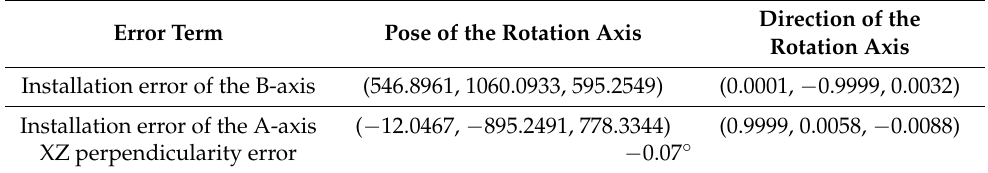
Figure 9. The measurement data’s distribution: ( a ) Before calibration; ( b ) after the calibration of the pose of the rotation axis; ( c ) after the calibration of the pose of the rotation axis and the XZ perpendicularity. Table 4. The results of the calibration of the measurement